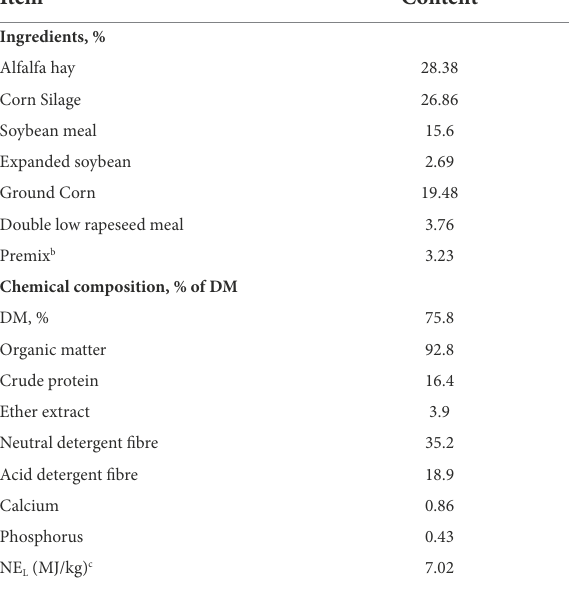
TABLE 1 Ingredients and chemical composition of experimental diets.